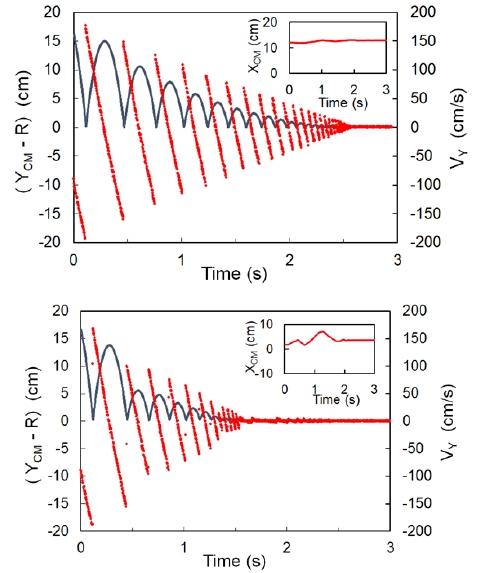
Fig. 1. Example of the evolution of the vertical coordinate of the centre of mass (left axis) and velocity (right axis) while the particle relaxes to equilibrium after successive bounces. Inset: Evolution of the horizontal coordinate of the centre of mass. Top panel and inserted figure: disk. Bottom panel and inserted figure: faceted